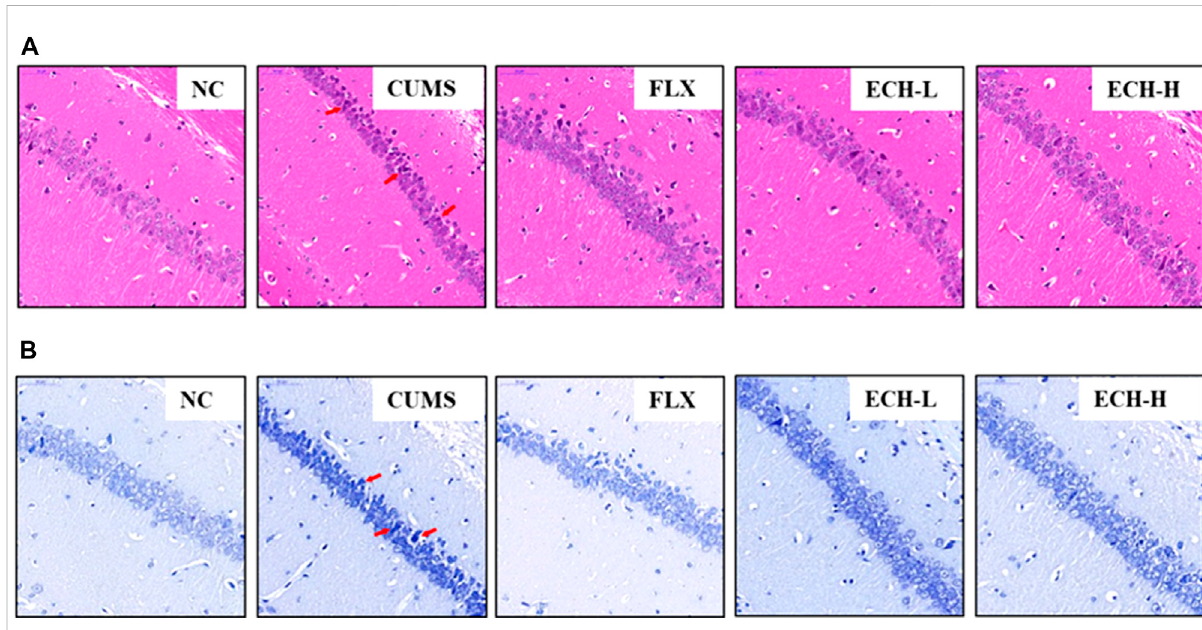
Effects of ECH on hippocampal Pathological Changes in CUMS Mice. NC, un-treated normal mice; CUMS, mice were treated with the chronic stimulating factors for 7 weeks to set up the CUMS depression model; FLX, CUMS induced mice were administered with fl uoxetine (10 mg/kg,i.g.) daily for 21 days; ECH-L, CUMS induced mice were administered with echinacoside (15 mg/kg,i.g.) daily for 21 days; ECH-H, CUMS induced mice were administered with echinacoside (60 mg/kg,i.g.) daily for 21 days. (A) hematoxylin and eosin (HE) staining of CA1 sub fi elds (400× magni fi cation), scale bar = 50 μ m; (B) Nissl staining of CA1 sub fi elds (400× magni fi cation), scale bar, 50 μ m.